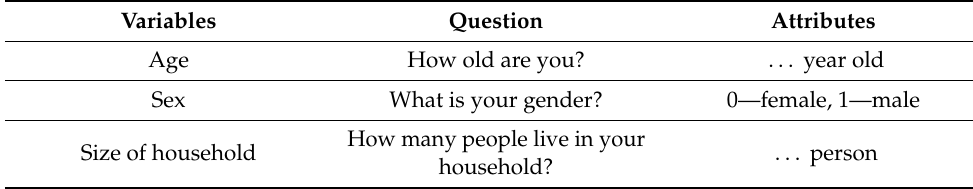
Table A1. Independent variables of the regression